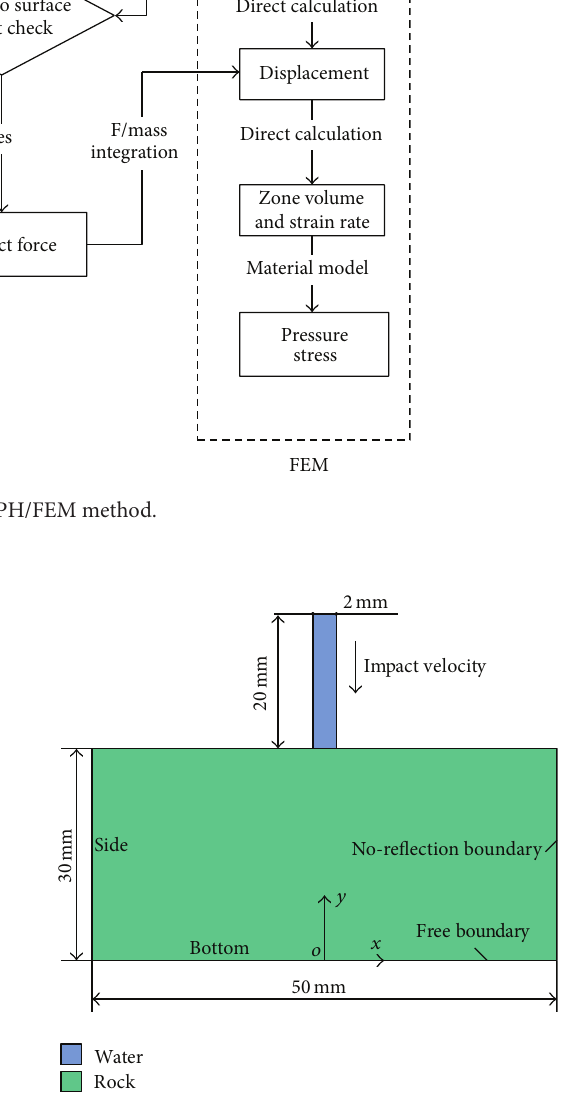
Figure 2: Geometric